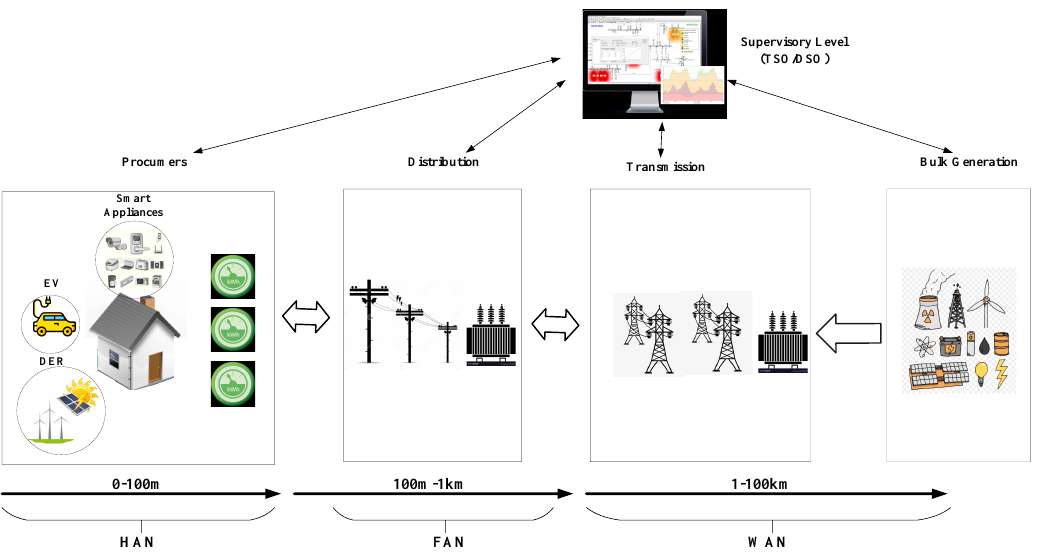
Figure 3. Communication level in the smart